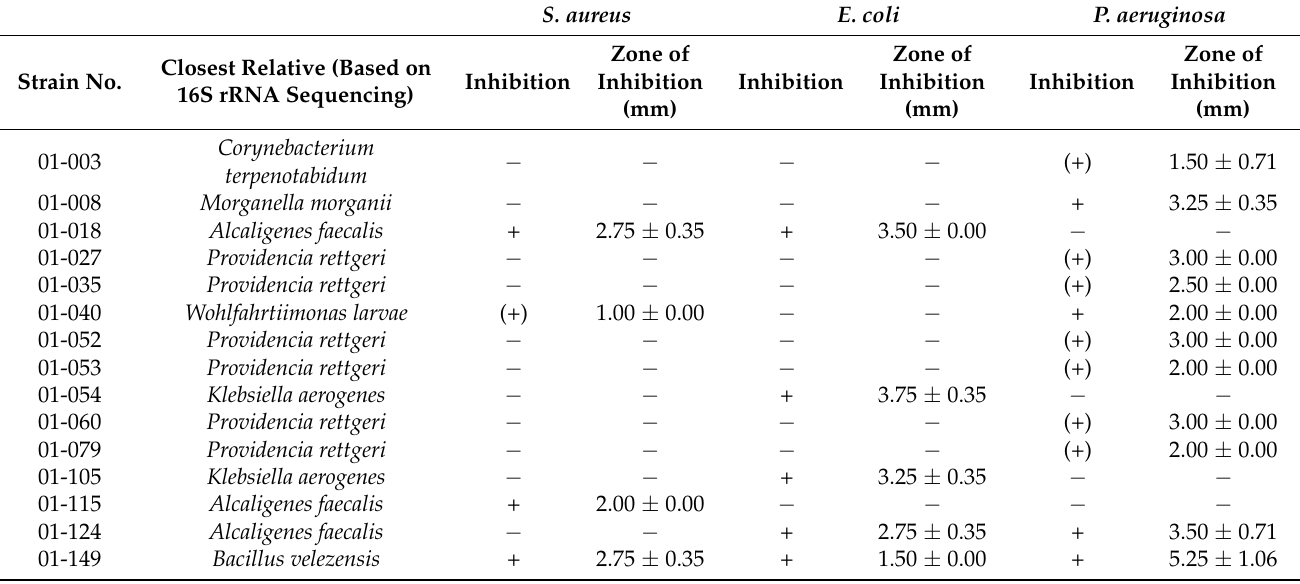
Table 1. Activity of selected isolates against the pathogens Staphylococcus aureus (DSM 799), Escherichia coli K12 and Pseudomonas aeruginosa (DSM1117). Only isolates that showed activity are shown. Full clearance is indicated by +, partial clearance is indicated by (+) and no clearance is indicated by − . Values are means ± standard deviations of duplicate tests.